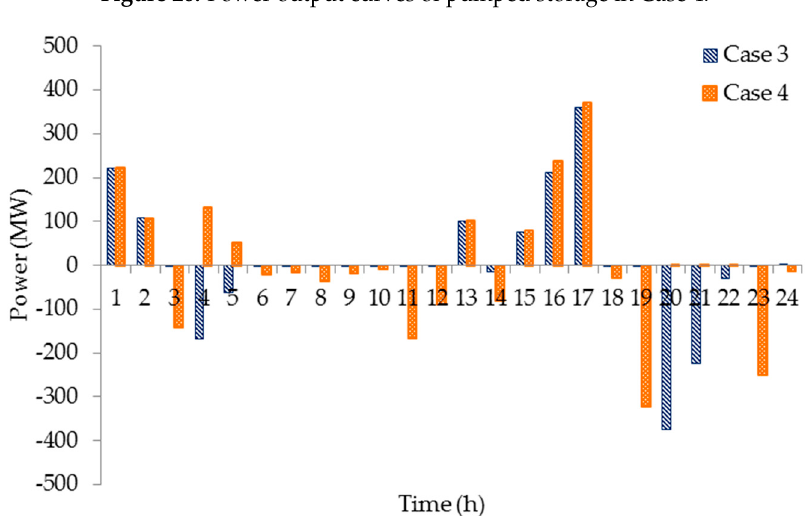
Figure 21. Power output comparisons of pumped storage in Case 3 and Case 4.